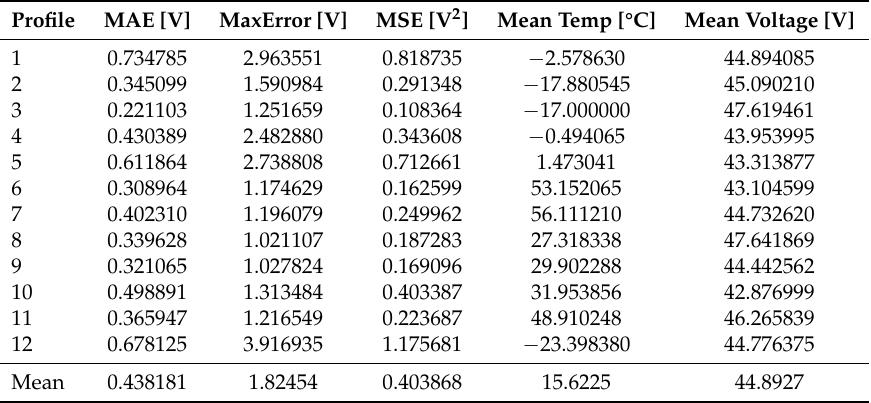
Figure 8. Voltage ( a ) and error ( b ) validation result for a current profile at 27 °C and a SOC range from 84% to 89%. Table 4. Validation errors of the test set